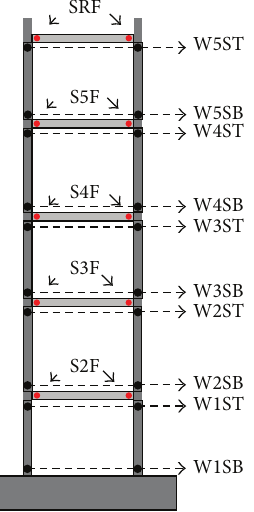
Figure 6: Updating parameters for damaged